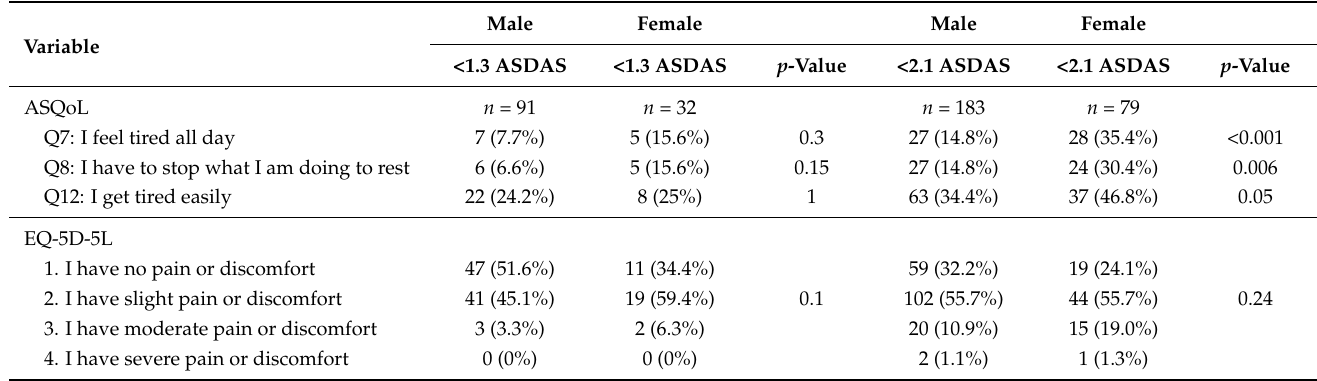
Table 5. Quality of life in patients with axial spondyloarthritis using ASQoL and EQ-5D-5L stratified by sex and